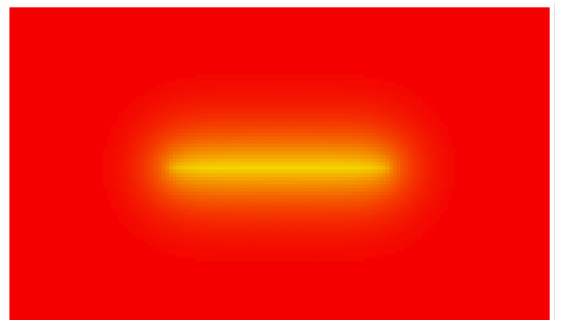
Figure 2. Early Time Pressure around Hydraulic Fractured